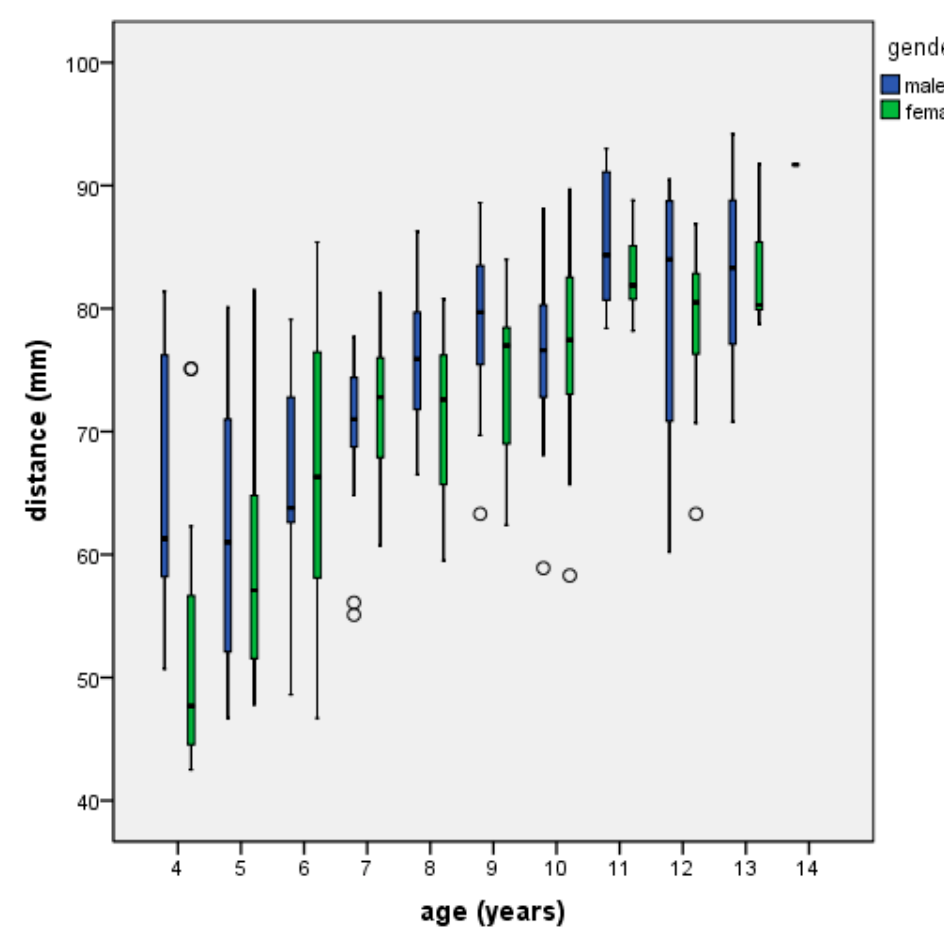
Figure 3. Boxplot displaying the descriptive statistics of the nostril to nasopharynx distance (mm) according to age (years) and gender.